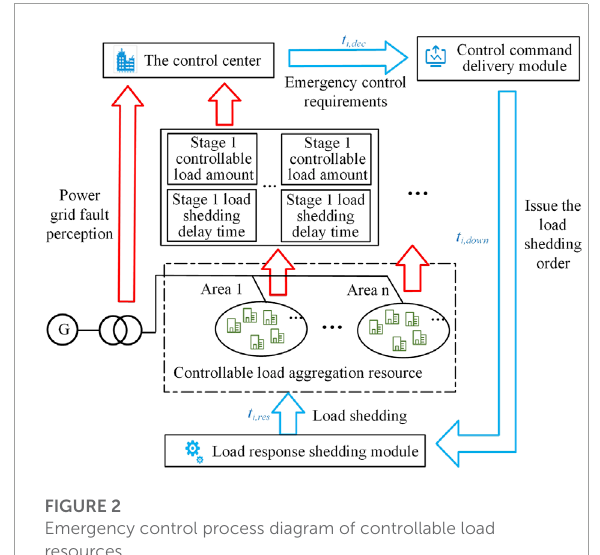
FIGURE 2 Emergency control process diagram of controllable load